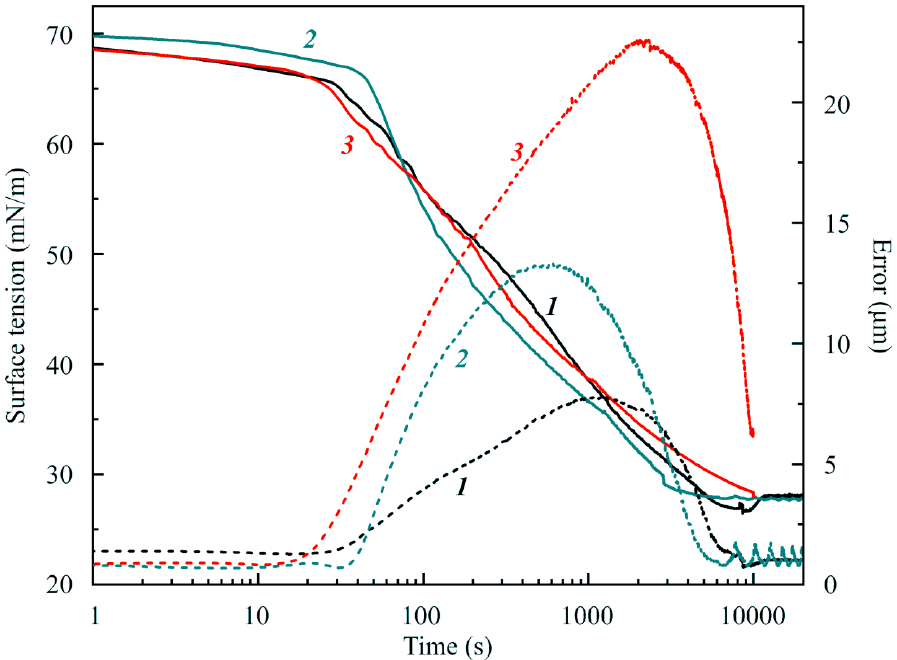
Figure 2. The same as in Figure 1 for the capillary of 2 mm in diameter and initial drop volumes of 1 , 6.5; 2 , 10 and 3 , 13 mm 3 , with a drop surface area of 15, 20 and 25 mm 2 , respectively.